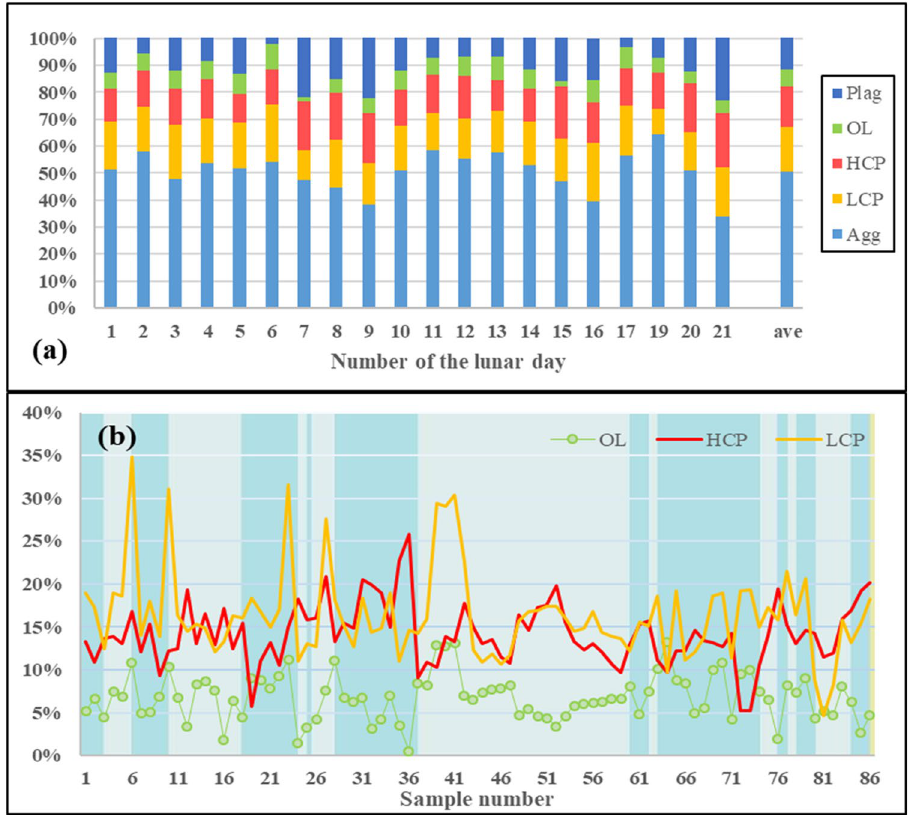
Figure 3. ( a ) The abundance of lunar materials during the first 21 lunar days. The estimated results show an average modal composition of 50.5% agglutinates (AGG), 16.3% LCP, 14.8% HCP, 6.1% olivine (OL) and 12.3% plagioclase (PLG). The ave means the average value during the first 21 lunar days. ( b ) The detailed abundance information for every VNIS detection during the first 21 lunar days. We use the background of the color bars to distinguish the observations during a lunar day.